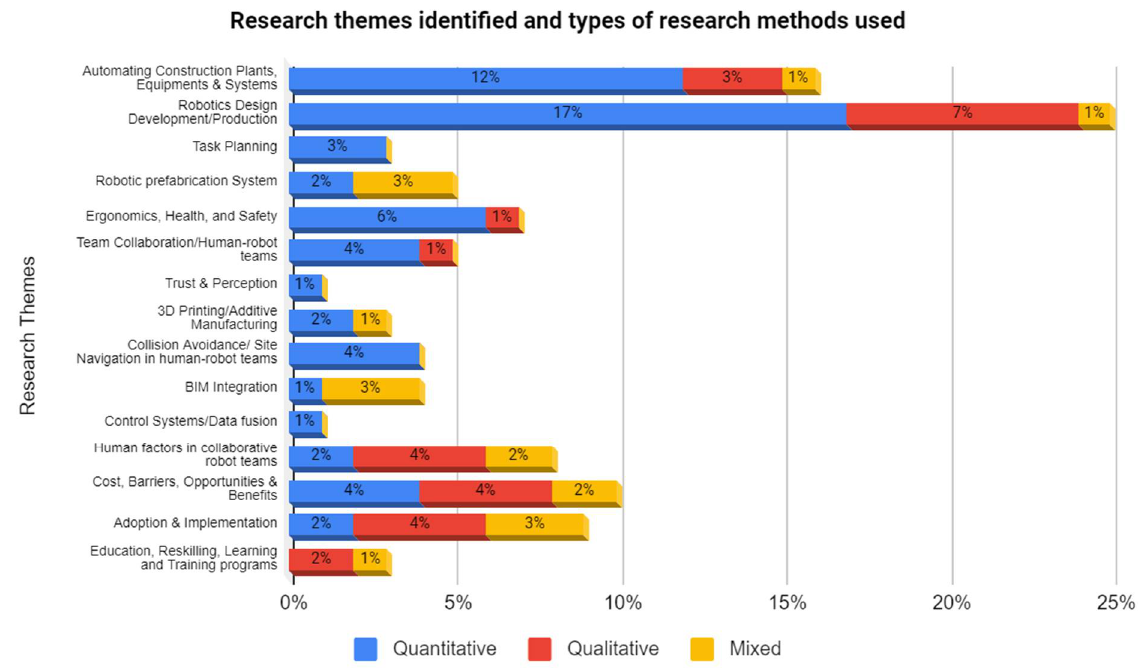
Figure 5. Research themes identified and types of research methods adopted.